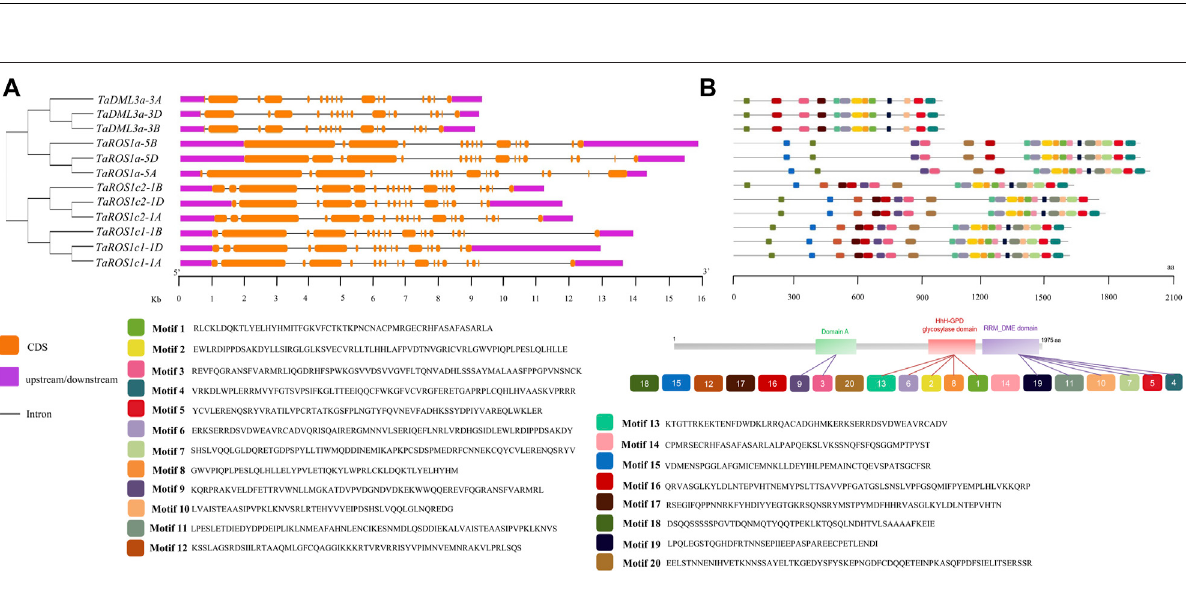
Frontiers in Genetics |